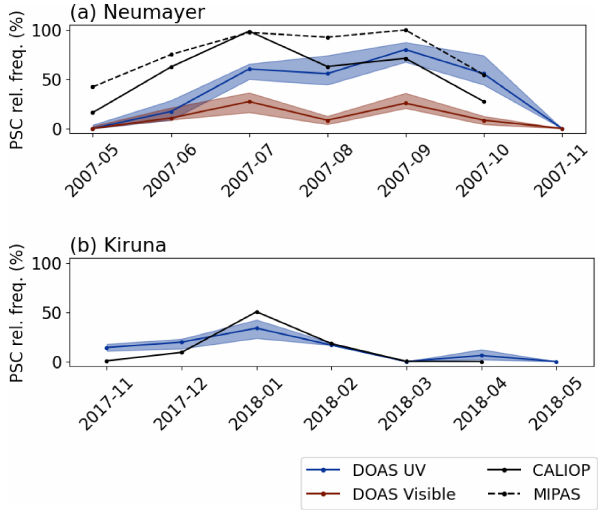
Figure 10. The occurrence of PSCs is depicted for the DOAS in- struments (blue, red) as well as CALIOP (black solid) and MIPAS (black dotted) data above (a) the Neumayer station in the winter of 2007 and (b) Kiruna in the winter of 2017/2018.